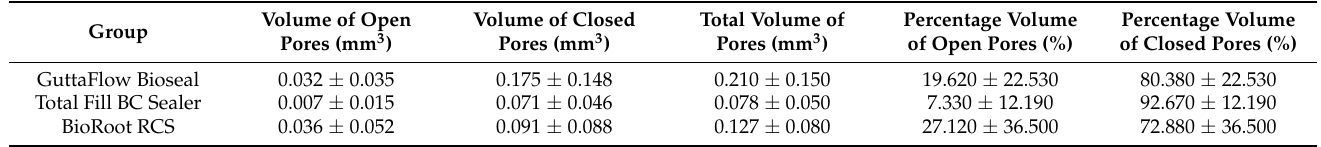
Table 2. Initial volume and percentage of open and closed pores.